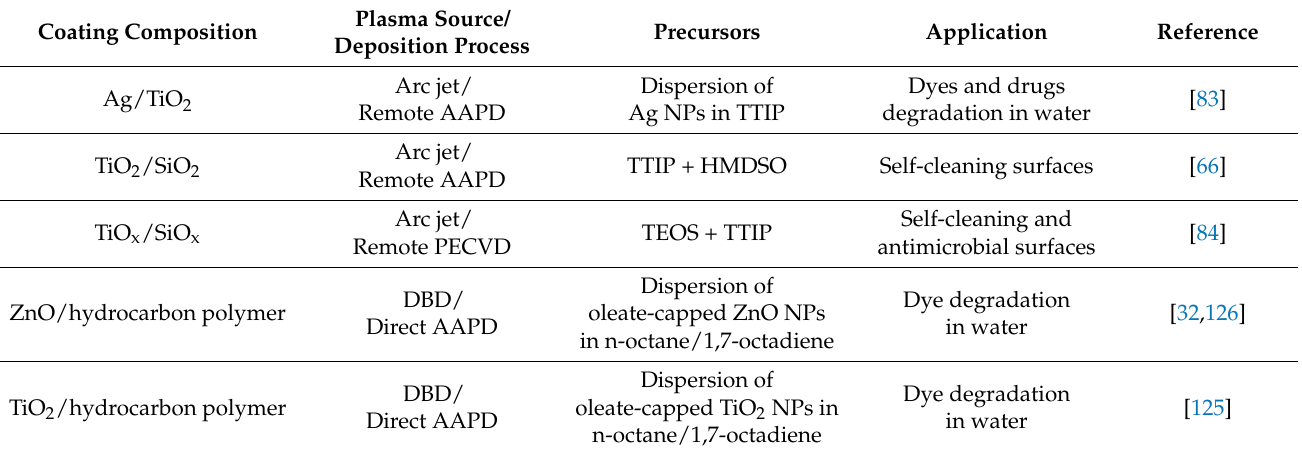
Table 1. Representative studies on photocatalytic NC coatings deposited by APPs. Plasma Source/ Coating Composition Deposition